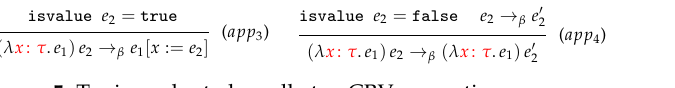
Figure 5. Typing-adapted small-step CBV